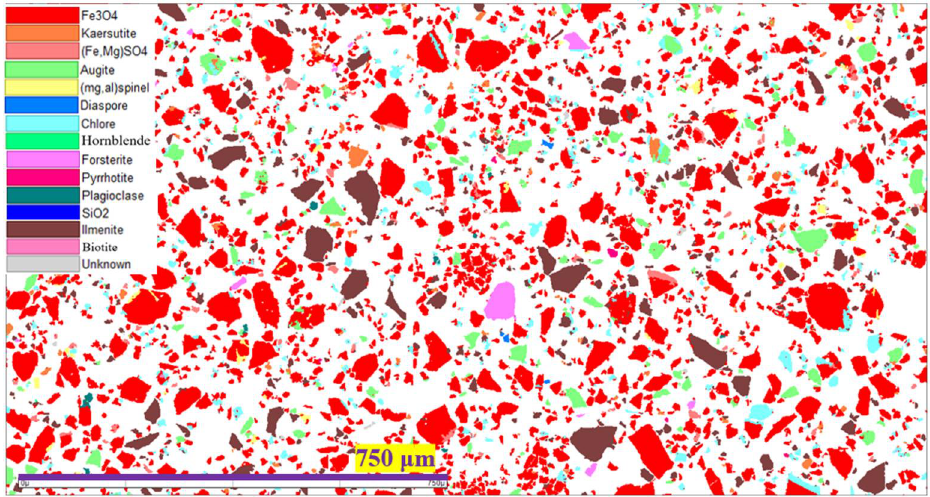
Figure 10. MLA distributions of the dissociated minerals (in different colors) after grinding.